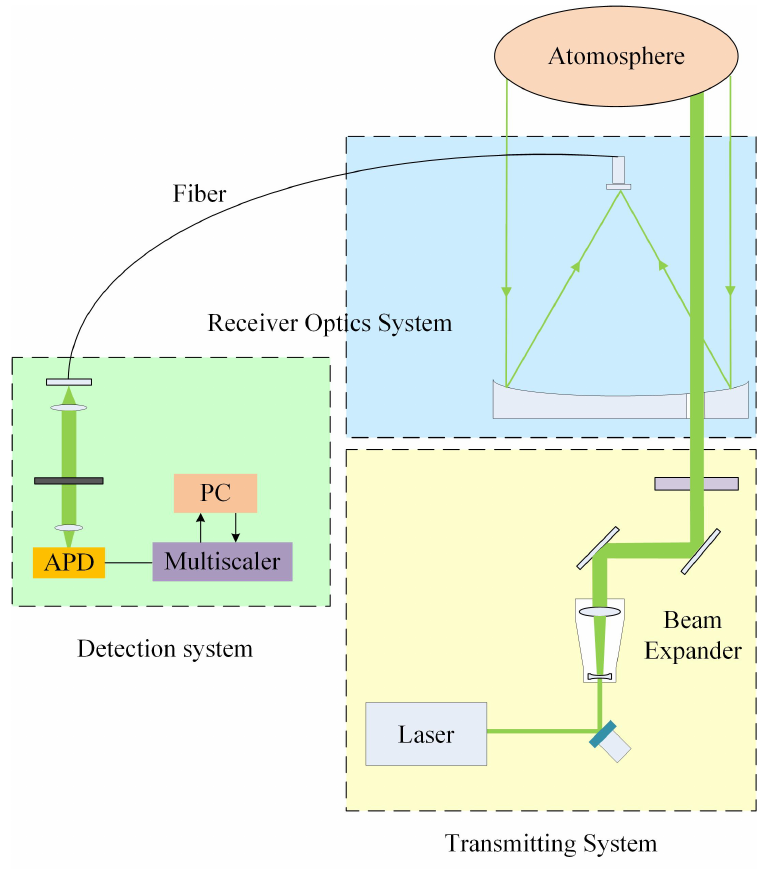
Figure 1. Schematic diagram of the Rayleigh lidar